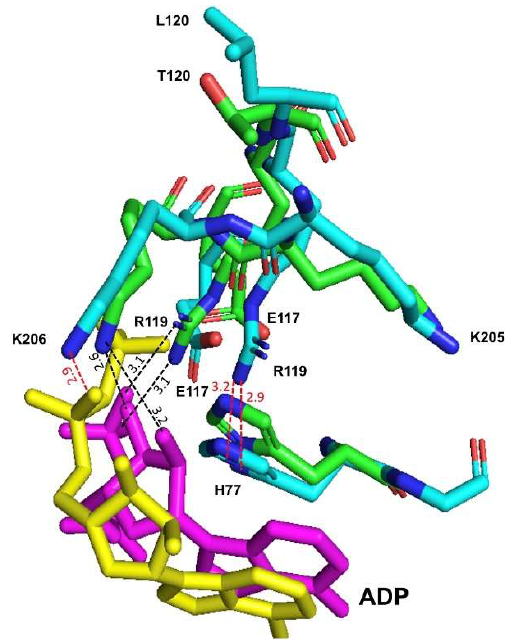
Figure 8. Comparison of the interactions of ADP (magenta and yellow) in the active site of the WT-RMPK (green) and T120L mutant (cyan). In the WT-RMPK, NH 2 of R119 is at H-bond distance (3.13 and 3.11 Å) of O3B and O1B of ADP, respectively. In contrast, in the T120L mutant, NH 2 of R119 is at 2.92 and 3.16 Å of ND1 and CE1 of H77, respectively. In WT-RMPK, NZ of K206 is at H-bond distance (2.57 and 3.19 Å) of O3 ´ and O2 ´ of ribose, respectively; whereas in T120L mutant, NZ of K206 is at H-bond distance (2.96 Å) of O1A of ADP. This figure was prepared using the molecular dynamic models of both enzymes in the initial structures described in Figure 7 from PDB